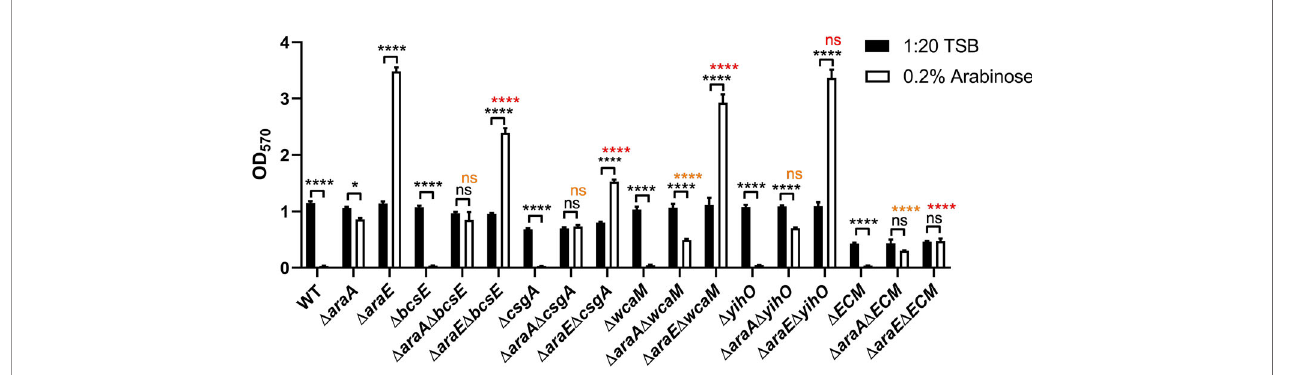
FIGURE 4 | Bio fi lm formation in the presence of L-arabinose partly depends on the ECM. WT 14028, D araA , D araE , and various combinations of ECM mutant strains were grown in 96-well plates in 100 µL 1:20 TSB (black bars) or 1:20 TSB with 0.2% L-arabinose (white bars). After 24 hours, planktonic cells were removed, then bio fi lms were washed, heat fi xed, and stained with crystal violet (CV) for relative bio fi lm measurement as determined at OD 570 . Data are mean ± SD, statistical analyses were done using a two-way ANOVA with Dunnett ’ s multiple comparisons test NS, not signi fi cant ( P >0.05); * P < 0.05; **** P <0.0001. Orange text compares D araA in 0.2% L-arabinose to its respective double mutant in 0.2% L-arabinose. Red text compares D araE in 0.2% L-arabinose to its respective double mutants in 0.2%